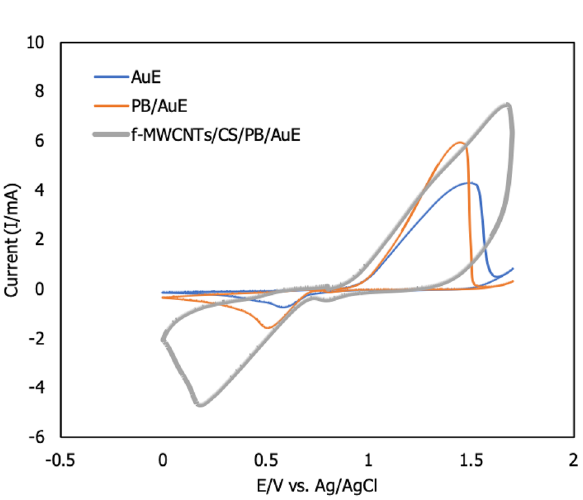
Figure 9. Comparison current signal on different modified electrodes in the presence of 3 ppm Zn 2+ ( n =